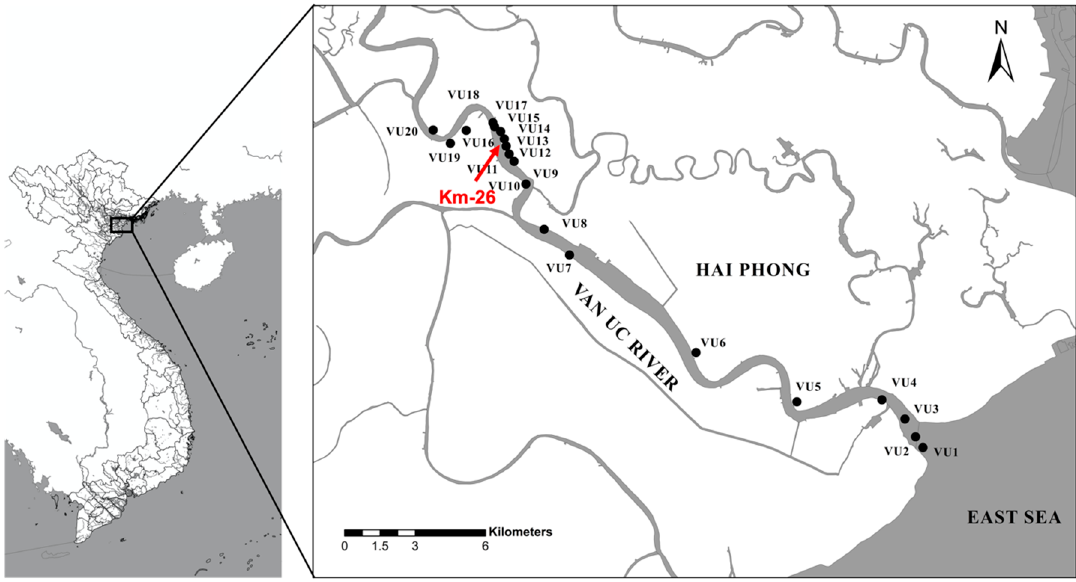
Figure 1. Map of the sampling sites along the Van Uc River. Table 1. Description of sampling